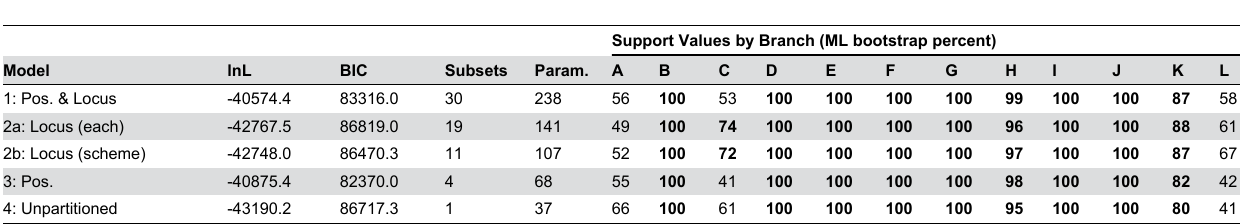
Table 4. Model comparison, by the Bayesian Information Criterion